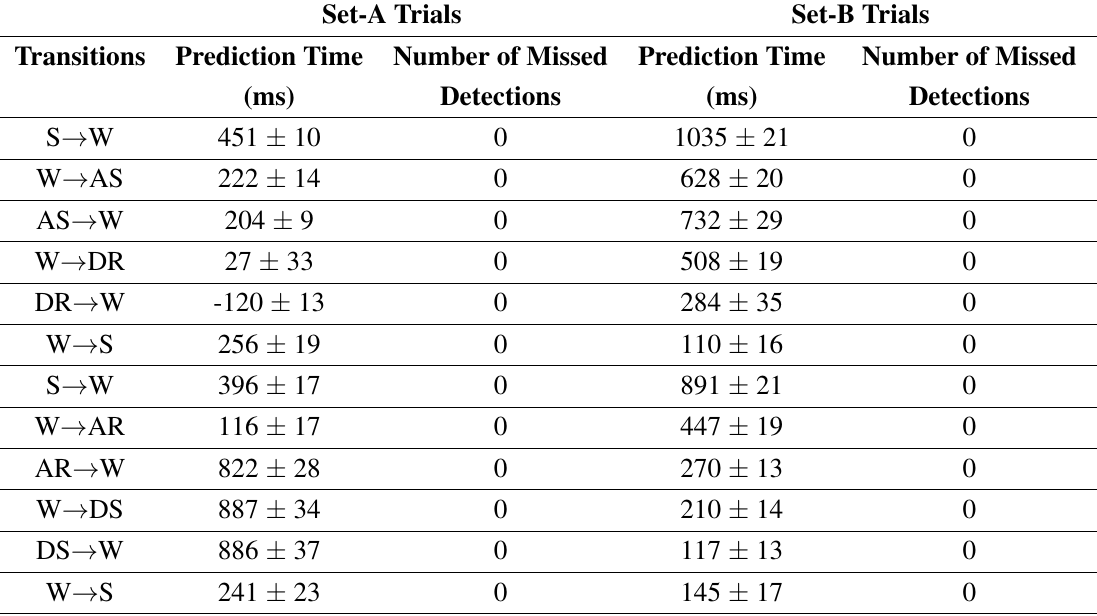
Table 3. Performance of Transition Detection (Mean (cid:6) SEM) for Seven Able-bodied Subjects in Locomotion Transition Periods. Set-A Trials Set-B Trials Transitions Prediction Time Number of Missed Prediction Time Number of Missed (ms) Detections (ms) Detections